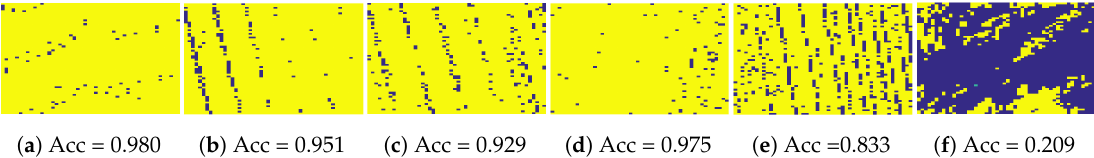
Figure 10. Classification results for the Bovine minced meat class. Spots in Bovine minced meat class represent spectral misclassifications of Ovine minced meat class and Acc represents the accuracy of the Bovine class for each sample.